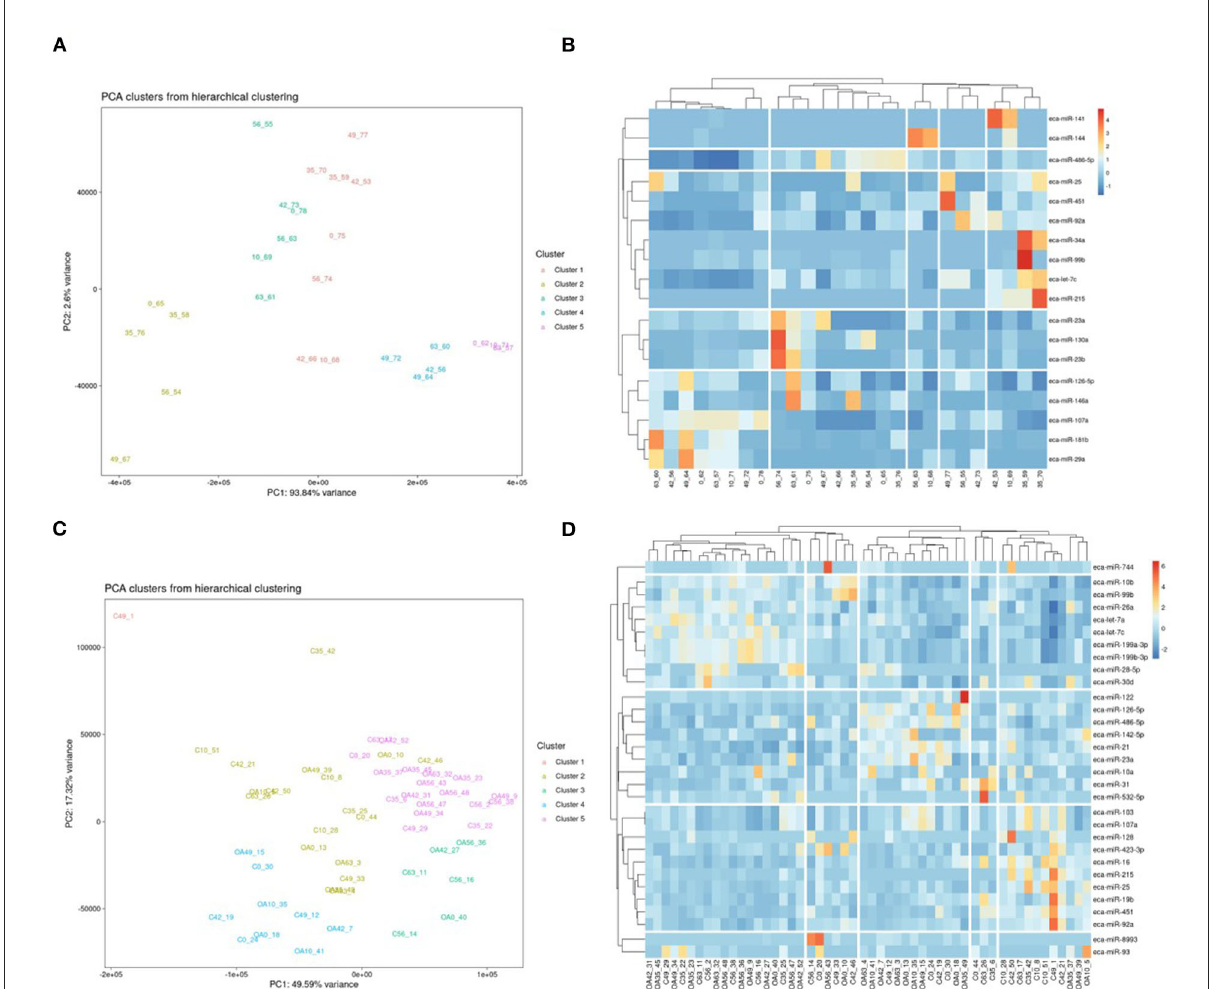
FIGURE4 Summary of data following small noncoding RNA sequencing of plasma and synovial fluid-derived EVs. (A) PCA of differentially expressed (DE) miRNAs for plasma-derived EVs. (B) Heatmap of DE miRNAs ( p < 0.05) in plasma-derived EVs. (C) PCA of miRNAs for synovial fluid-derived EVs (C, control; OA, osteoarthritis). Numbering of samples: the first number is the day of sampling, 0, 10, 35, 42, 49, 56, and 63. The second number is the original sample ID ( n = 4 horses). (D) Heatmap of DE miRNAs ( p < 0.05) in synovial fluid-derived EVs. Heatmaps were created using the R pheatmap package. Clustering was conducted with the “average” method and by correlation distancing. Scaling is unit variance scaled expression and based on read counts. Clustering distances are based on Pearson